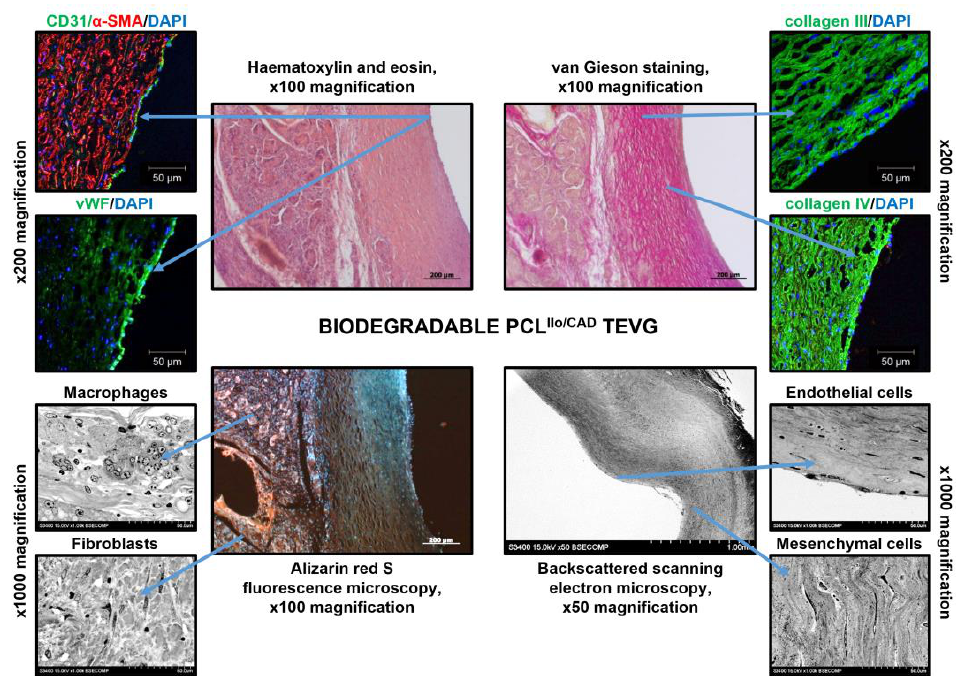
Figure 8. Microscopic examination of the TEVG implanted into the ovine carotid artery for 6 months. Centre: haematoxylin and eosin staining, van Gieson staining, and alizarin red S staining, ×100 magnification, scale bar: 200 µm (for EM-BSEM analysis: ×50 magnification, scale bar: 1000 µm). Left top: immunofluorescence staining for ECs (CD31 or vWF) and VSMCs (α -SMA), ×400 magnification, scale bar: 50 µm. Right top: immunofluorescence staining for medial collagens (type III and type IV), ×400 magnification, scale bar: 50 µm. Nuclei are counterstained with DAPI. Left bottom: EM-BSEM analysis, macrophages and fibroblasts, ×1000 magnification, scale bar: 50 µm. Right bottom: ECs and mesenchymal cells, ×1000 magnification, scale bar: 50 µm.